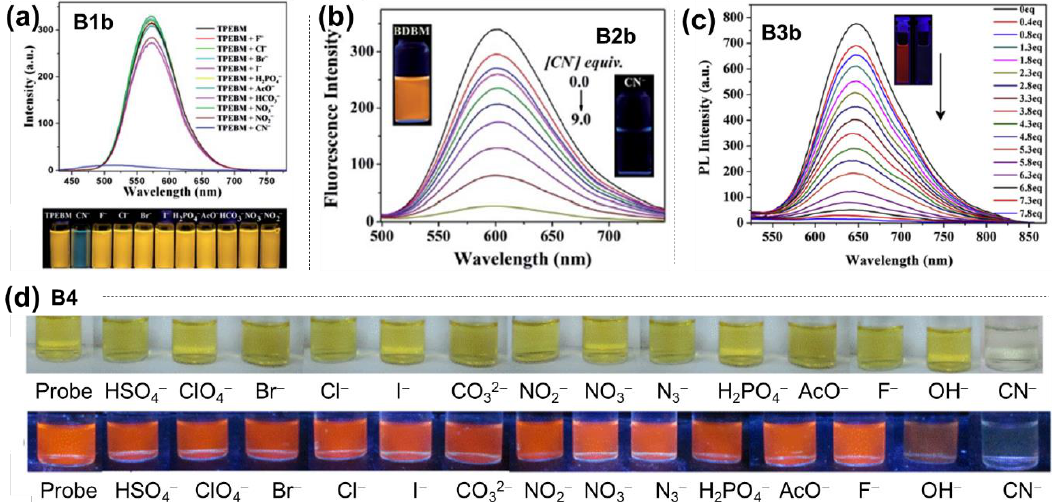
Figure 6. ( a ) Photoluminescence spectra and photos showing the selective quenching of orange fluorescence of B1b in aqueous solution. Reproduced with permission from [73]. Copyright 2014, the Royal Society of Chemistry. ( b ) Spectrofluorometric titration of B2b with cyanide with photos showing quenching of orange emission. Reproduced with permission from [74]. Copyright 2015, the Royal Society of Chemistry. ( c ) Spectrofluorometric titration of B3b with cyanide with photos showing quenching of red emission. Reproduced with permission from [76]. Copyright 2016, Elsevier B. V. ( d ) Photos showing the selective decolourisation and quenching of orange emission of B4 by cyanide. Reproduced with permission from [77]. Copyright 2017, Wiley-VCH Verlag GmbH & Co. KGaA.